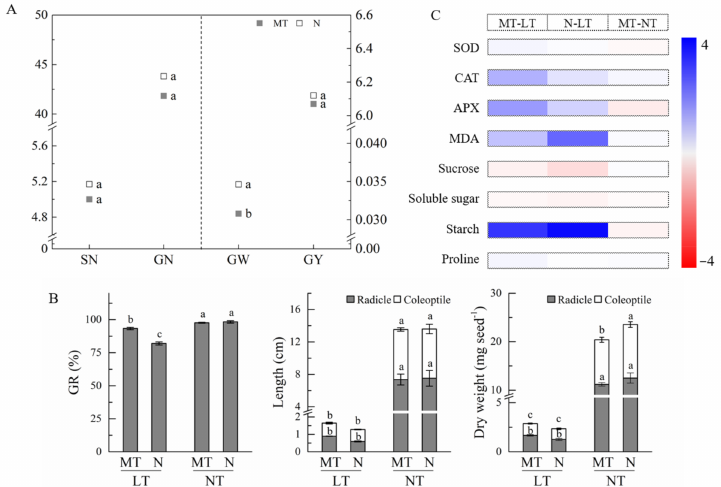
Figure 2. Effects of parental melatonin treatment during grain filling on offspring wheat germination under low temper- ature. ( A ), effects of spraying with melatonin during grain filling stage on grain yield of wheat at maturity. SN, spike number per plant; GN, grain number per spike; GW, grain weight; GY, grain yield per plant. Different small letters (a, b, and c) mean significant difference between treatments at p < 0.05 level. ( B ), effects of parental melatonin treatment during grain filling on seed germination rate (GR), length of radicle and coleoptile, and dry weight of radicle and coleoptile after 7 days′ germination of offspring wheat under low temperature. Different small letters mean significant difference between treatments at p < 0.05 level. ( C ), heatmap of antioxidant enzyme activity and metabolite concentration in germinating seeds as affected by parental melatonin treatment and low temperature. The difference of antioxidant enzyme activity and metabolite concentration among these treatments is deviation standardization and converted to a color